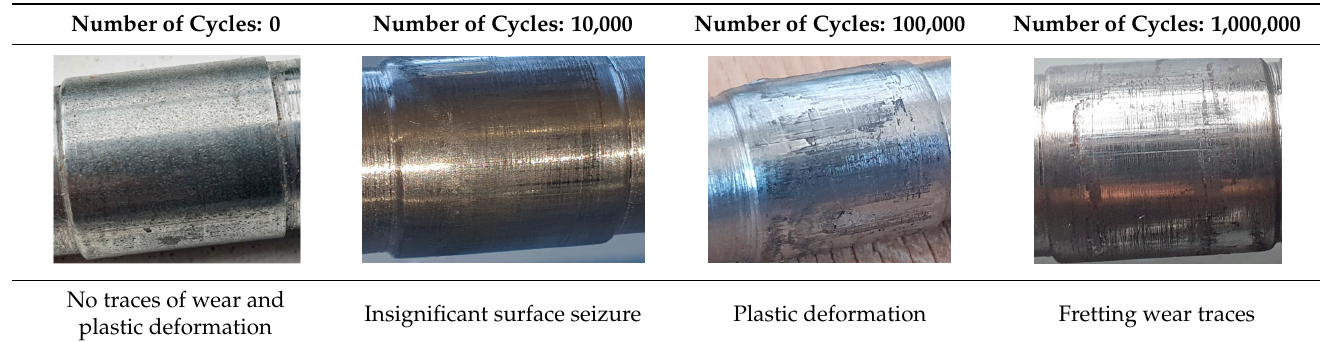
Table 5. Shaft surface condition after each fatigue cycle.